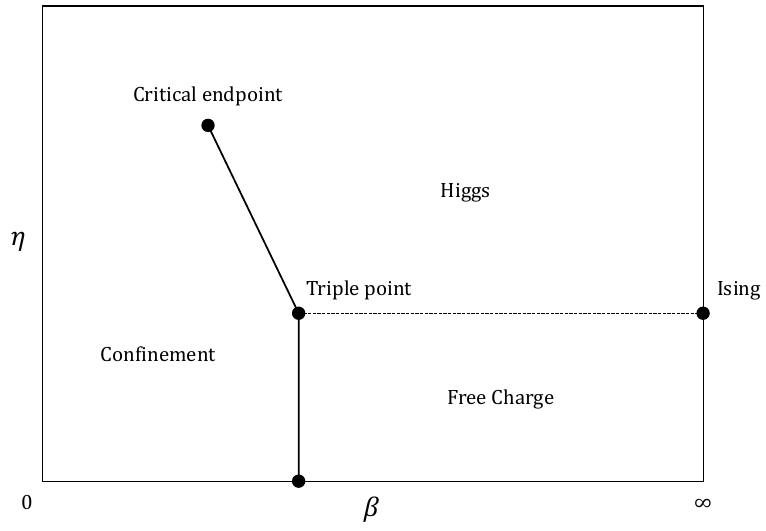
Figure 1 . Schematic phase diagram of (3+1) d Z 2 gauge-Higgs model at µ = 0 . The existence of the critical endpoint is established analytically [25–27] and numerically [28–31]. β -axis denotes the inverse gauge coupling and η represents the spin-spin coupling. Solid lines show the first-order phase transition and dotted line is the second-order transition line [32]. The pure Z 2 gauge theory is characterized by η = 0 and the limit β → ∞ is equivalent to the Ising